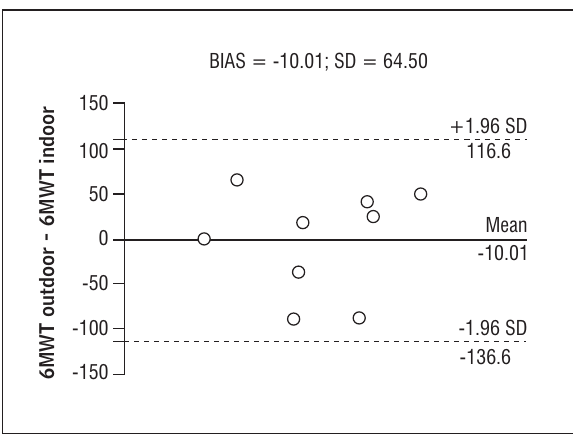
Figure 3 - Bland-Altman plots showing the walking distance difference on 6-min walk test between outdoor and